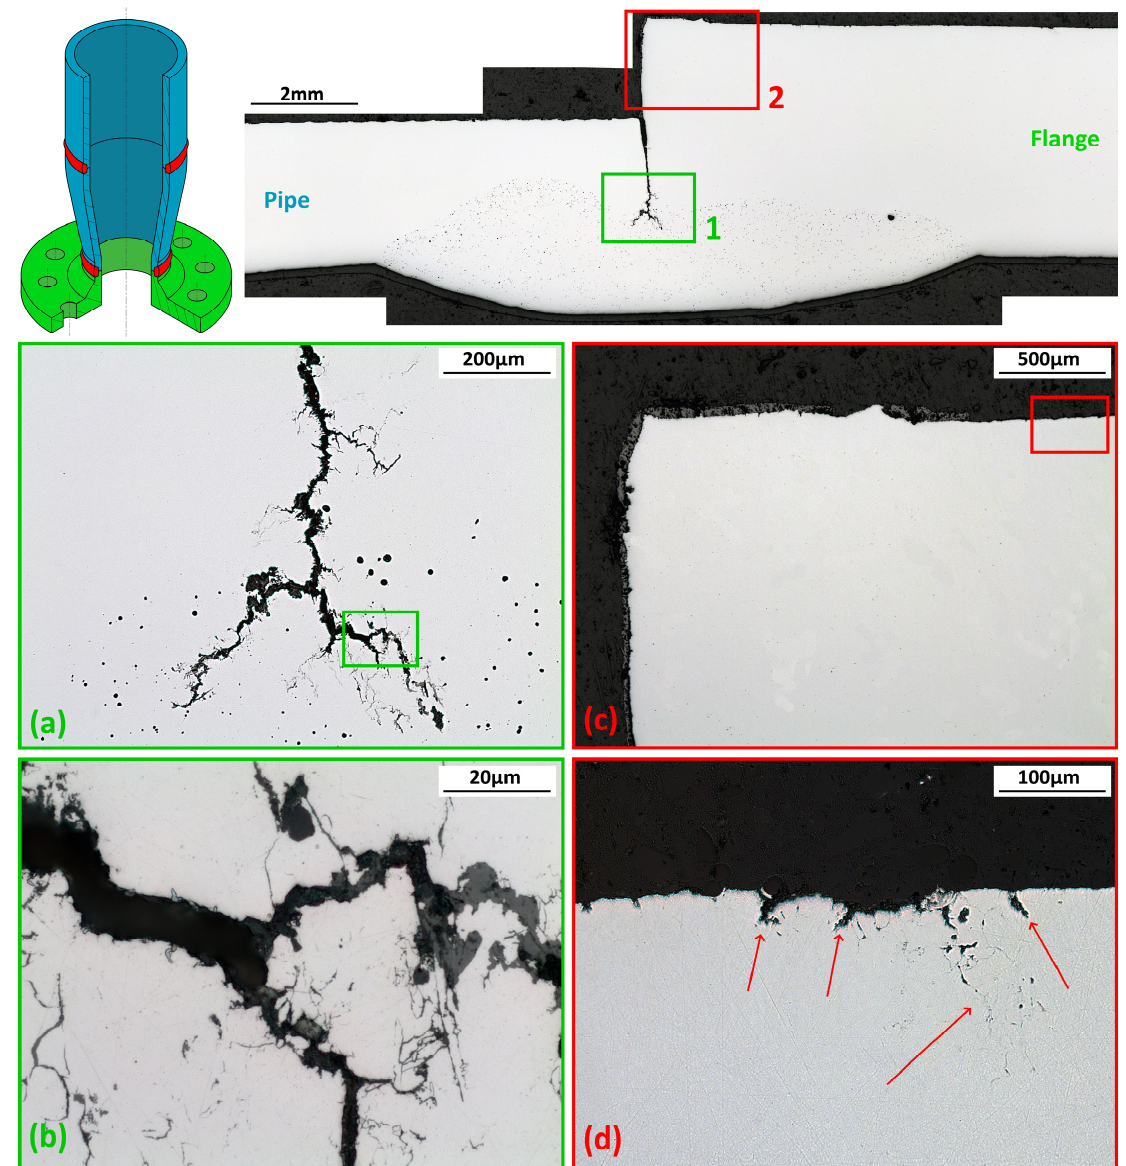
Figure 7. Metallographic analysis of one cracked region. All the cracks have a high number of secondary branches. Pictures ( a , b ) are magnifications of Zone 1, and pictures ( c , d ) are magnifications of Zone 2.